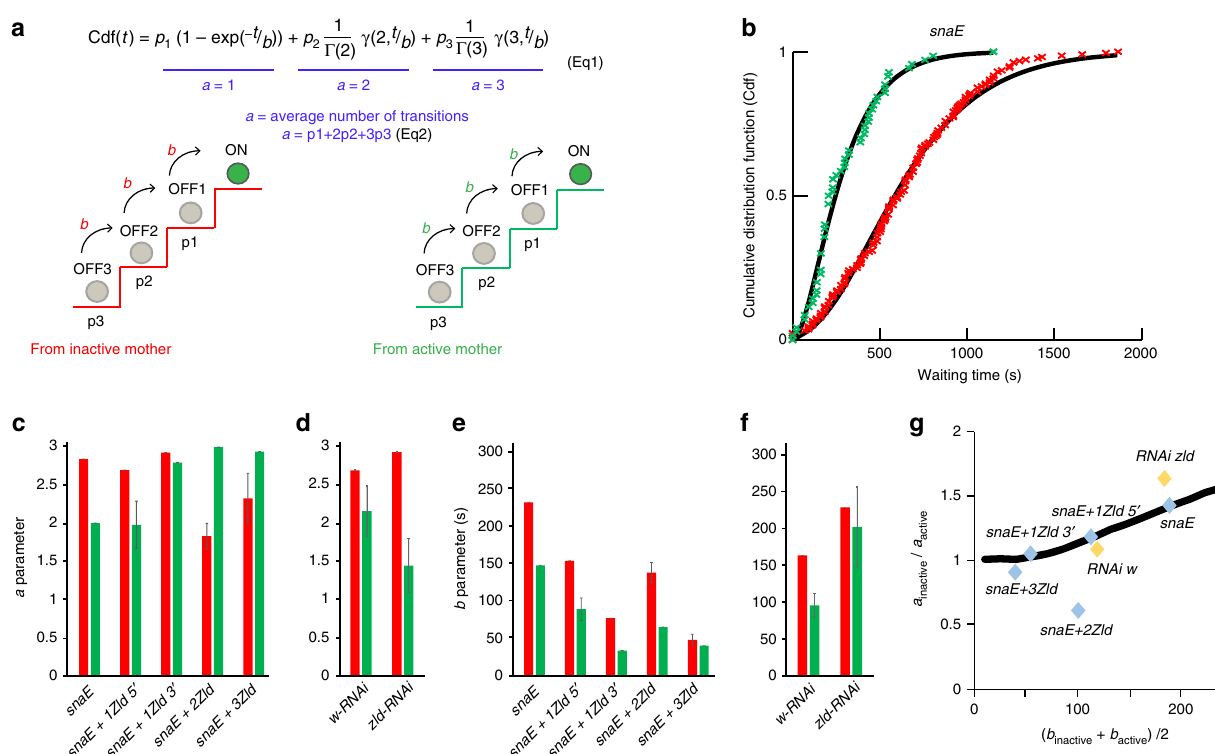
Fig. 4 Mathematical modeling of transcriptional memory. a Schematic representation of the discrete states (OFF1, OFF2 and OFF3) required to reach transcription (ON state), when coming from an inactive (red stairs) or an active (green stairs) mother nucleus. After mitosis, the probability for a nucleus to initiate the transcriptional activation process from a given state is provided by the parameter p , ( p 1 = p(OFF1), p 2 = p(OFF2) and p 3 = p(OFF3)). The distribution of the random time to transcription (t) is modeled as a mixture of gamma distributions, according to the displayed Equation 1, where Cdf is the cumulative distribution function, Γ and γ are the complete and incomplete gamma functions, respectively. The average number of transitions ‘ a ’ is provided by the sum of weighted probabilities (Equation 2). The time of each jump from one state to another is provided by the parameter ‘ b ’ . Parameters of this model are predicted separately for nuclei coming from active and inactive mothers. The parameter fi tting is based on Cdf of the random time to transcription in nc14 (t) (see also Supplementary Equation 1 Supplementary Methods). b Cdf of the random time to transcription in nc14. The origin of time is the end of mitosis nc13 to nc14, (determined by our automatic software, see “ Methods ” section) added to the time required to detect the fi rst activation (proper to each genotype). Data (cross) are compared to predictions (solid curves) for nuclei, resulting from active (green) and inactive (red) mothers. c , d Mean ‘ a ’ parameter; error intervals correspond to the variation among optimal and best suboptimal fi ts (see Supplementary Methods and Supplementary Data 1). e , f Mean ‘ b ’ parameter; error intervals correspond to variation among optimal and best suboptimal fi ts (see Supplementary Methods and Supplementary Data 1). g The ratio of parameter ‘ a ’ in subpopulations from inactive and active mothers is positively correlated